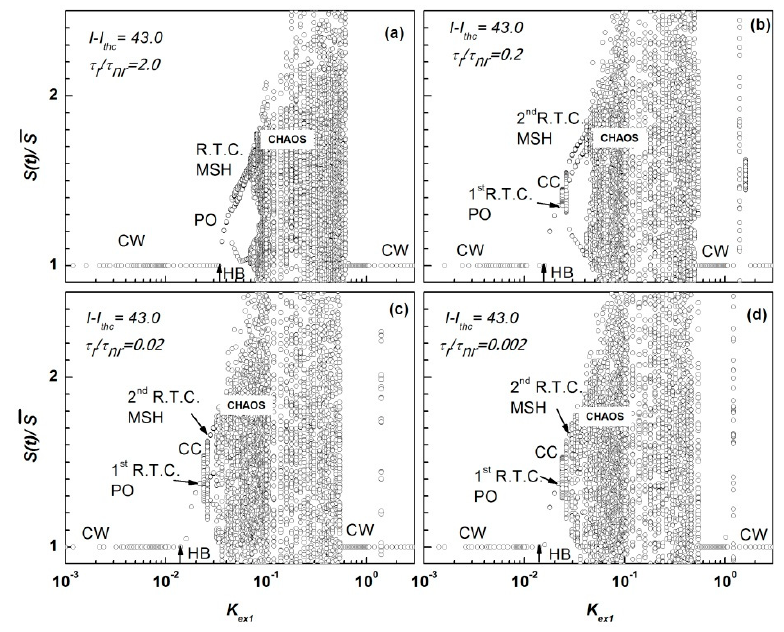
Figure 3. Operation states of an SL under OFB in terms of bifurcation diagrams, when ( I - I thc ) = 43.0 mA (substantially far from the threshold). ( a ) τ r / τ nr = 2.0, ( b ) τ r / τ nr = 0.2, ( c ) τ r / τ nr = 0.02, and ( d ) τ r / τ nr = 0.002.